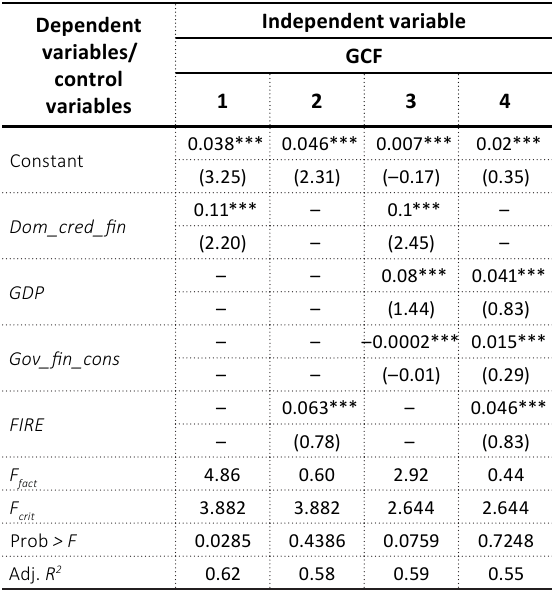
Table 5. Results of identifying the dependence between IMFR indicators and amount of